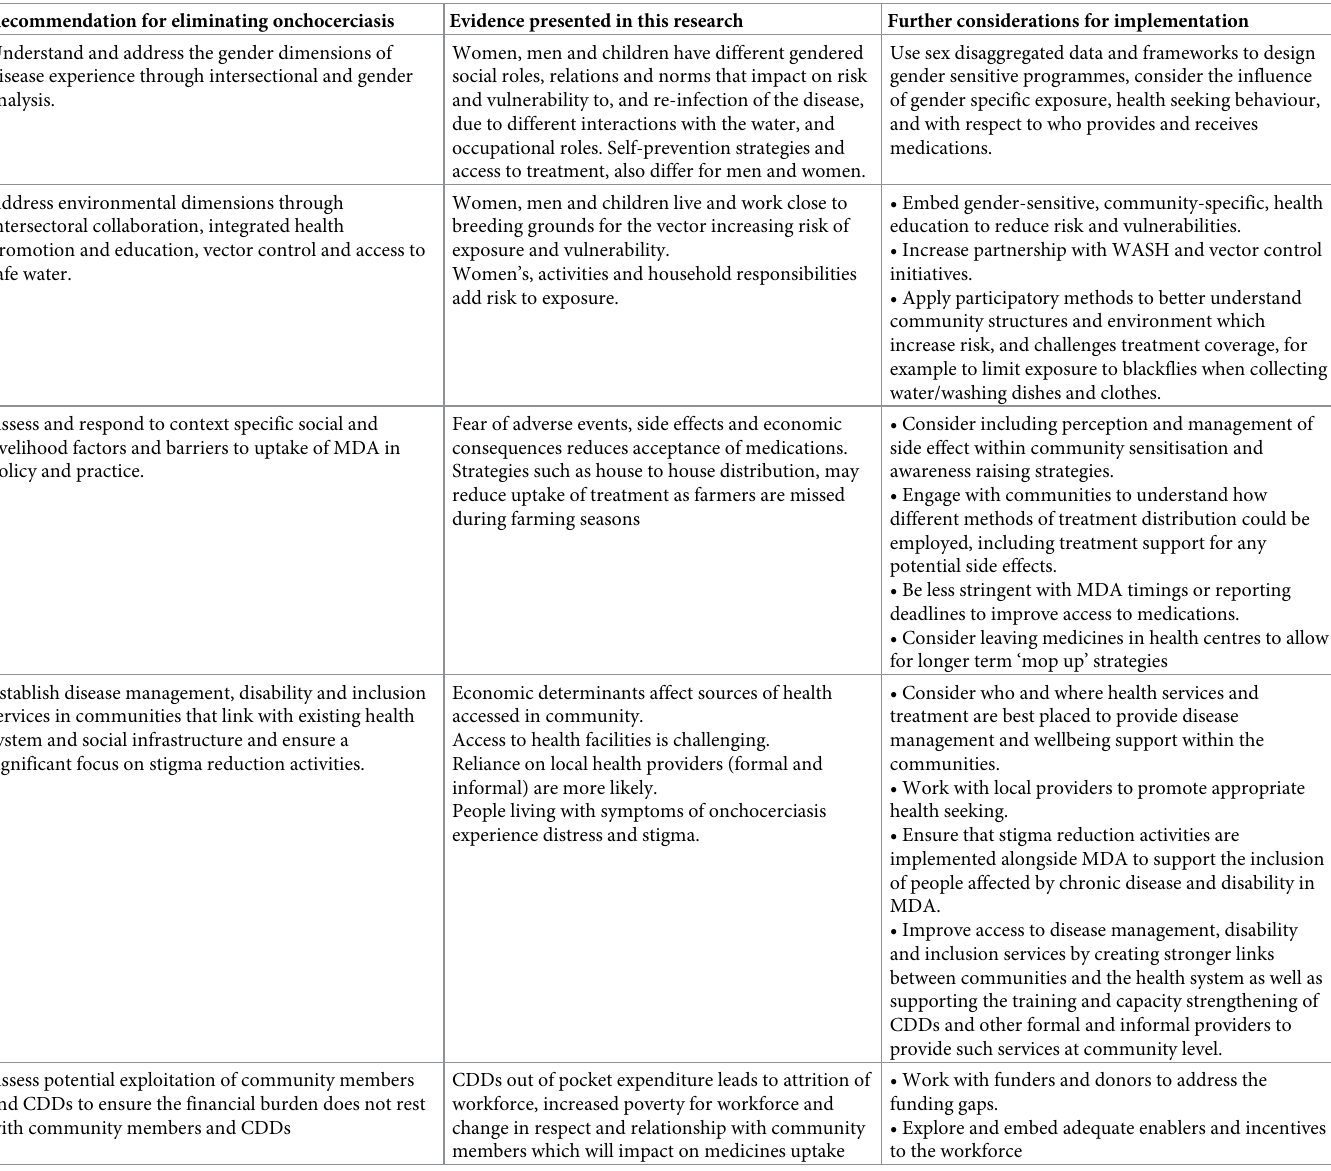
Table 2. Recommendations and further action needed for